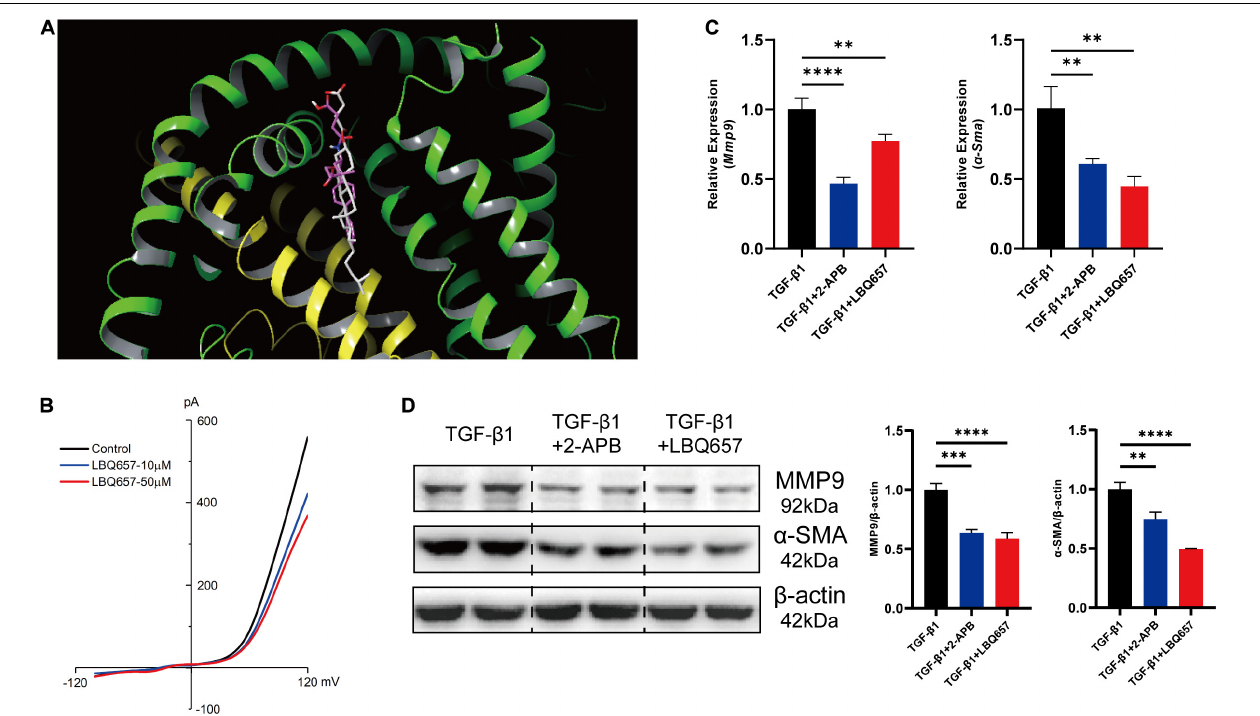
FIGURE 3 | LBQ657 protected against fibrosis by blocking TRPM7 channel. (A) The virtual binding mode of NEPi and natural cholesterol hemisuccinateon ligand (as control) on TRPM7. NEPi (red) and cholesterol hemisuccinate (gray) are shown as a stick model. (B) Current amplitude of TRPM7-like current recorded in neonatal rat cardiac fibroblasts in control cell (black), LBQ657-10 µ M treated cell (blue) and LBQ657-50 µ M treated cell (red). (C) mRNA expression of Mmp9 and α -Sma in MEF treated with TGF- β 1, MEF treated with 2-APB + TGF- β 1, and MEF treated with LBQ657 + TGF- β 1. (D) Protein levels of MMP9 and α -SMA in the rats. The data presented are mean ± SD. Each group contained the results of three independent repeated trials. 18S RNA was used as the internal reference gene and β -actin was used as the internal reference protein for normalization and statistical analysis. ∗∗∗∗ P < 0.0001, ∗∗∗ P < 0.001, and ∗∗ P <